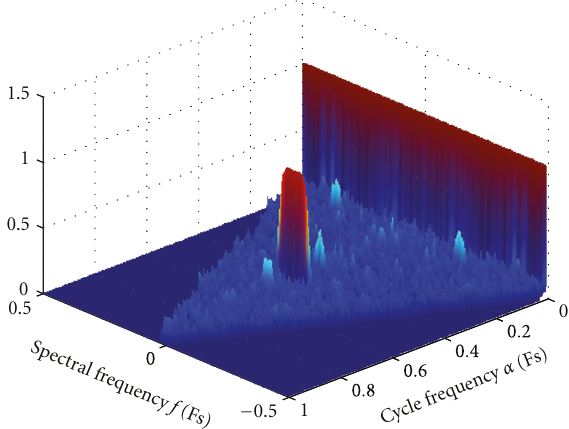
Figure 5: SOF of a 4-ASK signal in an AWGN Channel at 5dB SNR, with 1/Ts = Fs/10, Fc = 0.25 Fs, no. of samples = 4096.